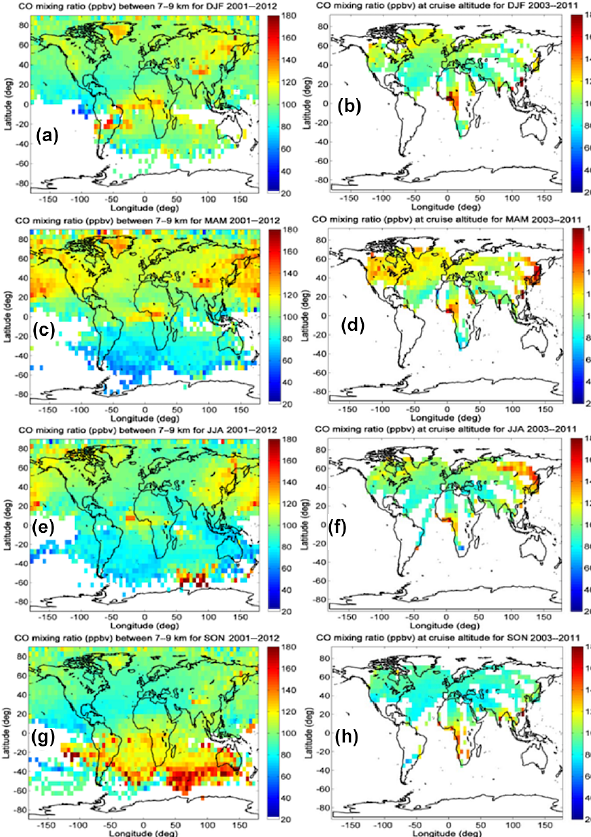
Figure 7. Global distribution of seasonal mean trajectory-mapped MOZAIC-IAGOS CO between 7 and 9km altitudes above sea level for the period from 2001 to 2012. Left: MOZAIC-IAGOS trajec- tory. Right: MOZAIC-IAGOS cruise